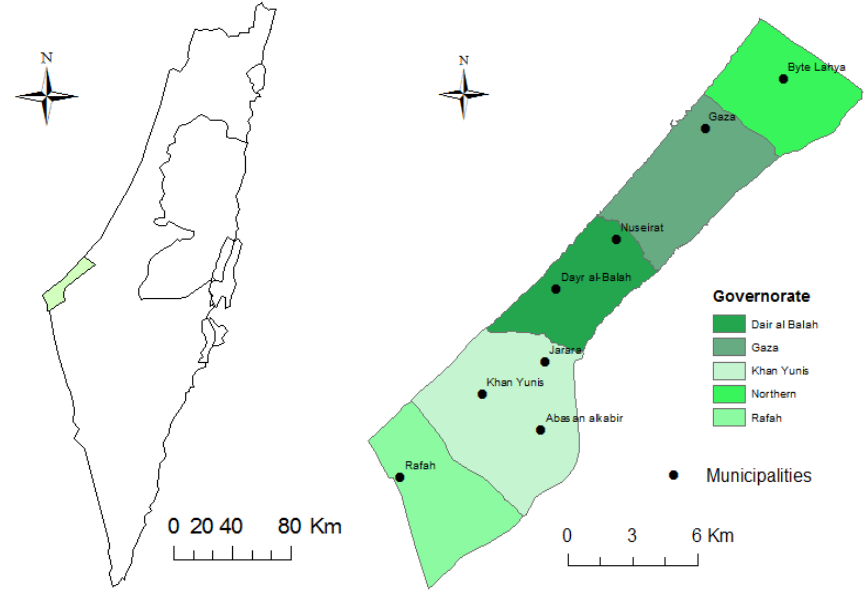
Figure 2. Cities and municipalities in the study area (GS).